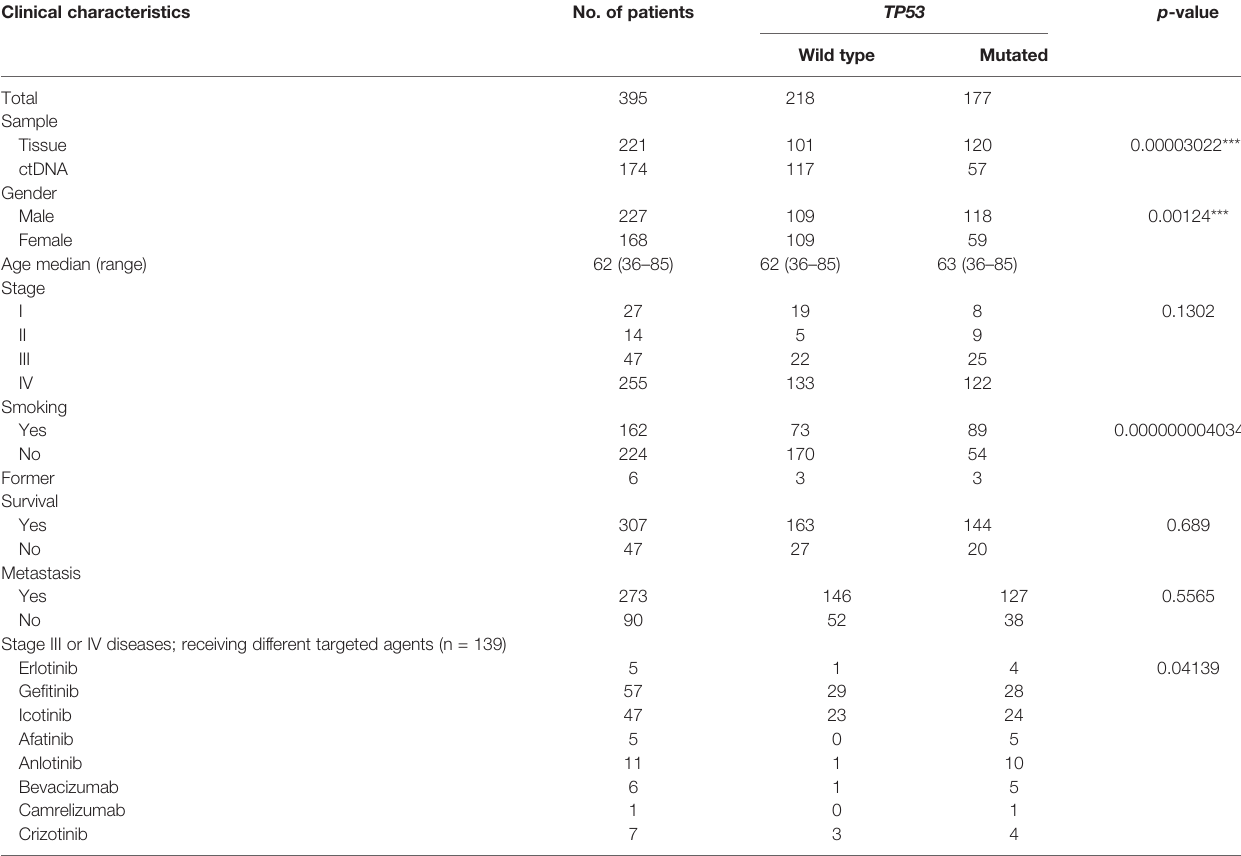
TABLE 1 | Clinical characteristics of patients enrolled in this study according to TP53 status. Clinical